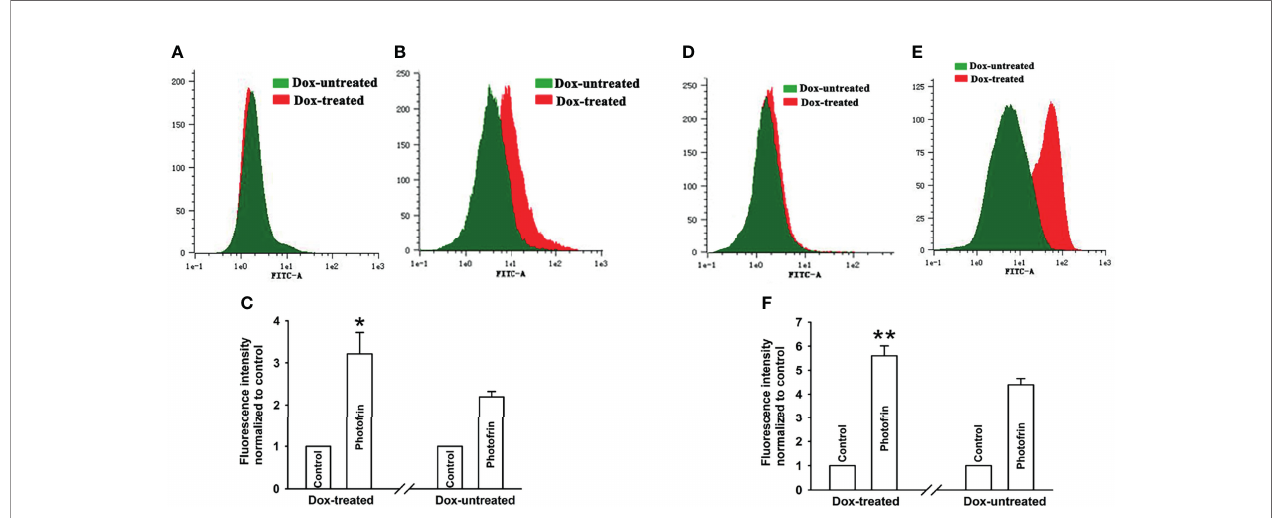
FIGURE 5 | Ca 2+ release and in fl ux were increased by Cx40-formed channels. After incubation with Fluo-3-Am, Dox-treated and Dox-untreated cells were irradiated with or without Photofrin. Flow cytometry was performed to measure the fl uorescence intensity of Ca 2+ after PDT. (A) control; (B) 2.5mg/mL Photofrin; (C) The fl uorescence intensity of Ca 2+ . For (A – C) , the cells were incubated in fresh BBS in the absence of Ca 2+ during irradiation. (D) control; (E) 2.5mg/mL Photofrin; (F) The fl uorescence intensity of Ca 2+ . For (D – F) , the cells were incubated in fresh BBS in the presence of Ca 2+ during irradiation. Data points are mean ± SD from 3 experiments. t test was used to assess statistically signi fi cant differences between groups. * P < 0.05, ** P < 0.01, signi fi cantly different from Dox-untreated